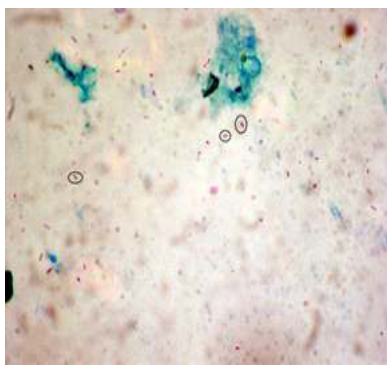
Figure-2. ZN staining of decontaminated fecal samples (with 0.75% HPC) showing red color AFB (Encircled with black solid line).